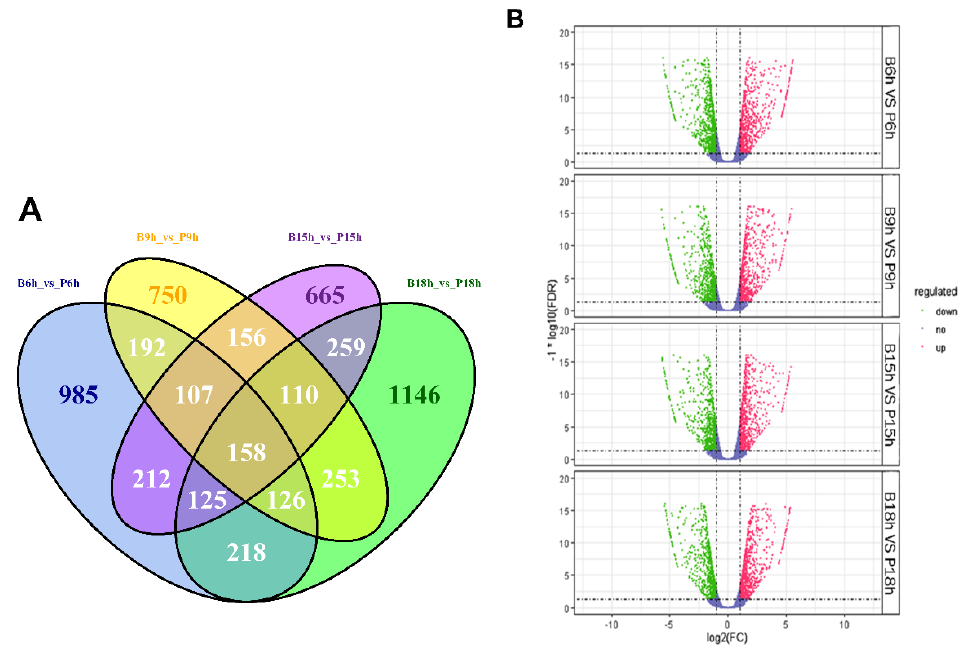
Figure 1. ( A ) Venn diagram of differentially expressed genes (DEGs) numbers in different comparisons (B6h vs. P6h, B9h vs. P9h, B15h vs. P15h, B18h vs. P18h). ( B ) Volcano plot of differentially expressed genes distribution trends among B6h vs. P6h, B9h vs. P9h, B15h vs. P15h, and B18h vs. P18h. The log 2 (fold change) indicates the mean expression level for each gene. Each dot represents one gene. Green and red dots represent upregulated and downregulated DEGs, respectively. Blue dots represent genes not differentially expressed.